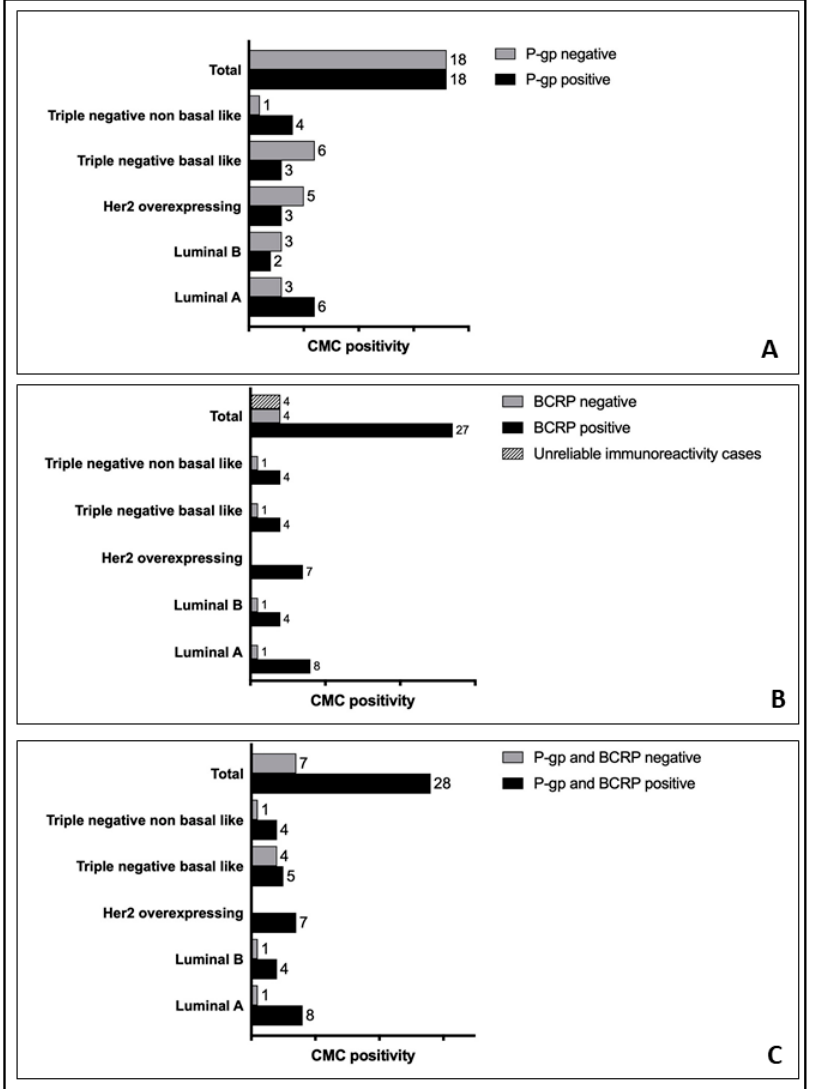
Figure 3. Graphic representation of the number of CMCs expressing P-gp (Panel A ), BCRP (Panel B ) or both markers (Panel C ) in CMCs’ immunophenotypes. No significant association was found among the expression of P-gp or BCRP and the immunophenotypes ( p > 0.05). All HER2-overexpressing CMCs expressed at least one of the two chemoresistance markers (7/7), and no case was BCRP negative. No statistical correlation was found among P-gp or BCRP expression or their co-ex- pression and the Ki67 index ( p > 0.05) or the histological grade ( p > 0.05). The Ki67 index